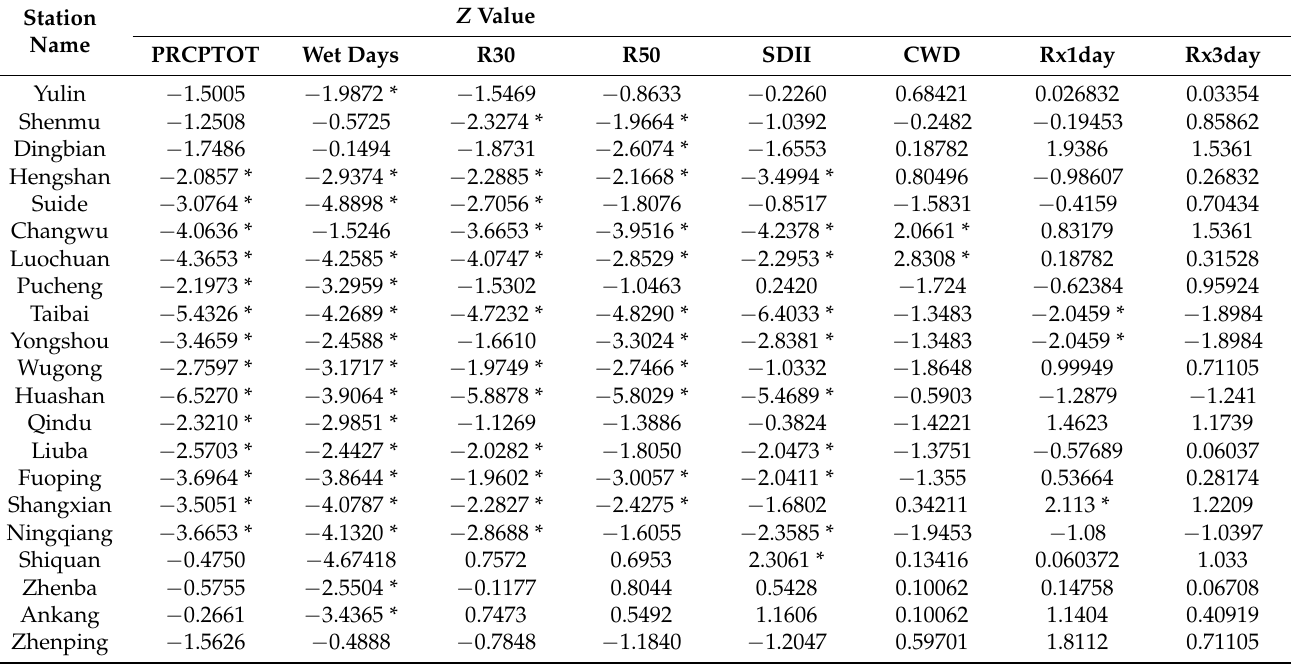
Table 4. Z value of precipitation-related